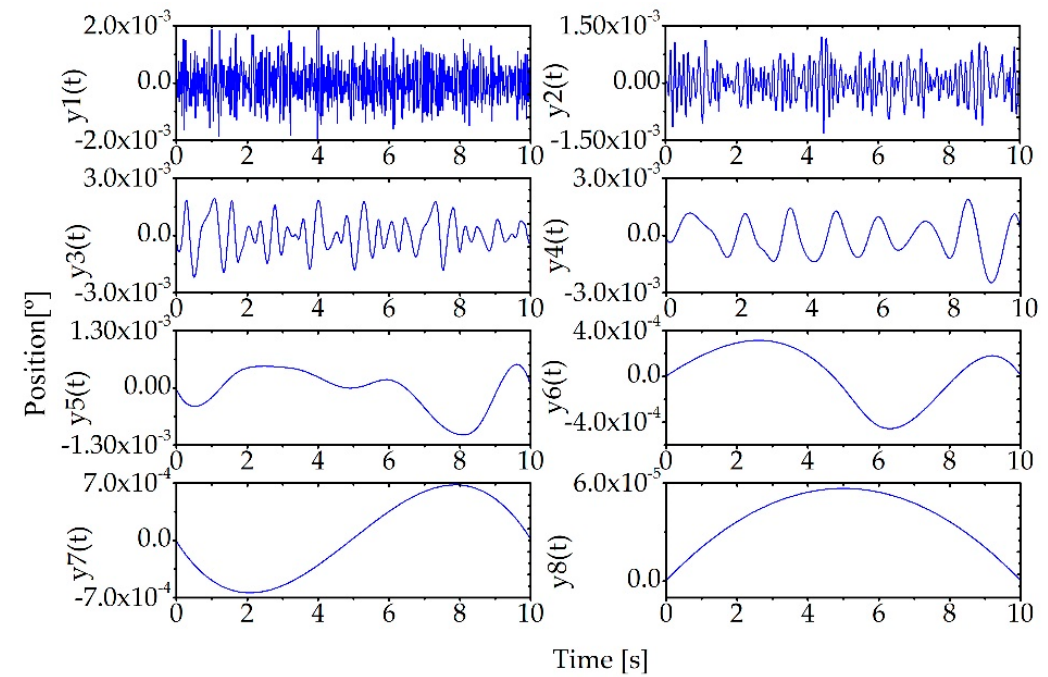
= + y y y in the oscillations noise